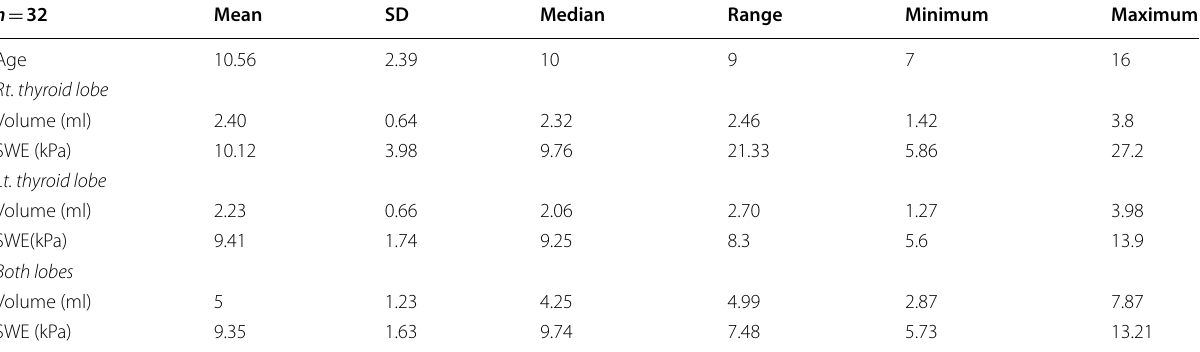
SD standard deviation; Rt right; Lt left; SWE shear wave elasticity; kPa kilopascals; ml